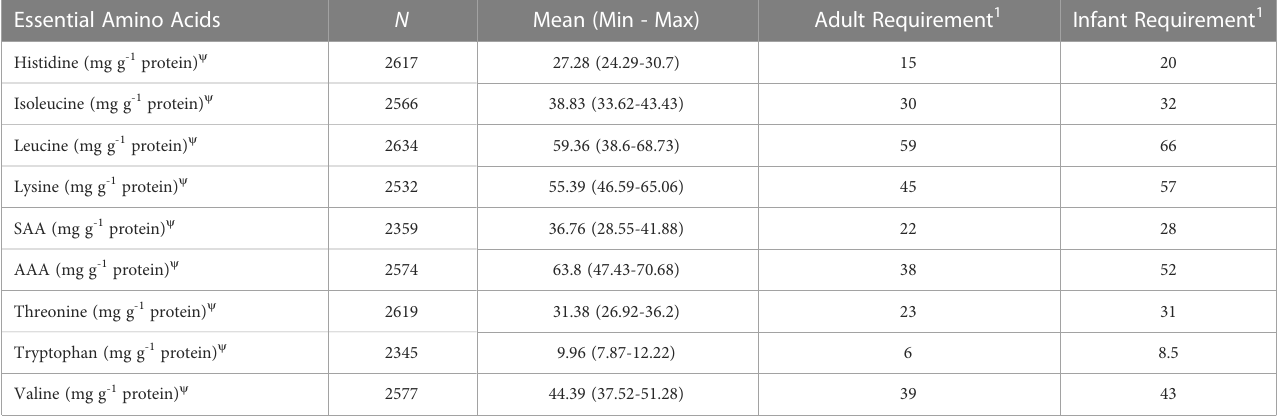
TABLE 6 Mean and range, from minimum (min) to maximum (max), number of valid samples ( N ) for essential amino acids, and their respective adult and infant daily requirements. Essential Amino